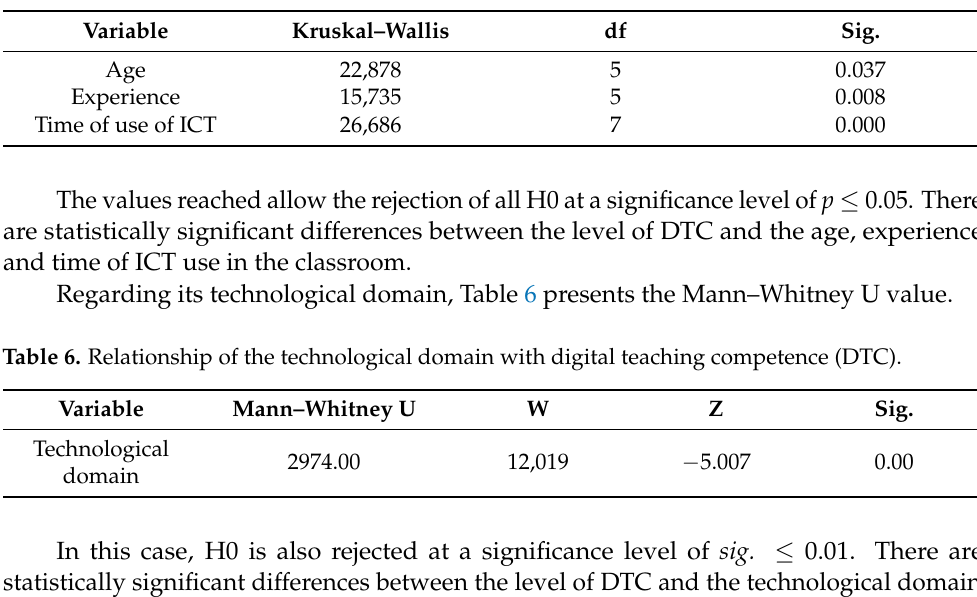
Table 5. Kruskal–Wallis tests: age, experience and use time.